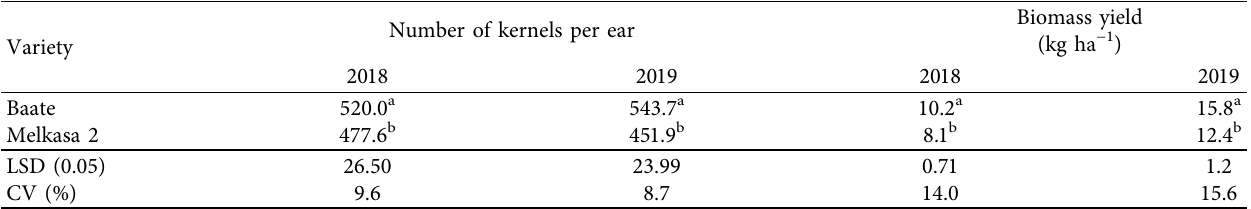
Table 7: Mean values of the number of kernels per ear, thousand kernel weight, and biomass yield as influenced by the main effect of variety in both